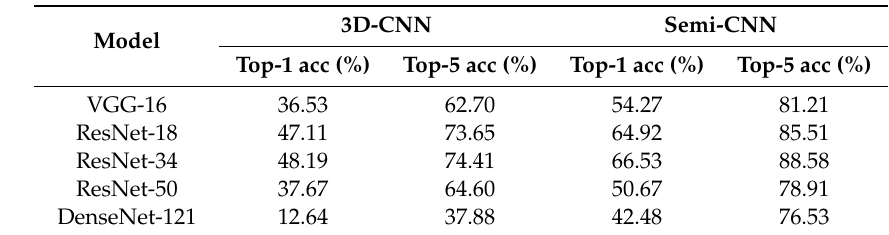
Table 3. Comparison of validation results for models VGG, ResNet and DenseNet, with 3D-CNN and semi-CNN architectures.